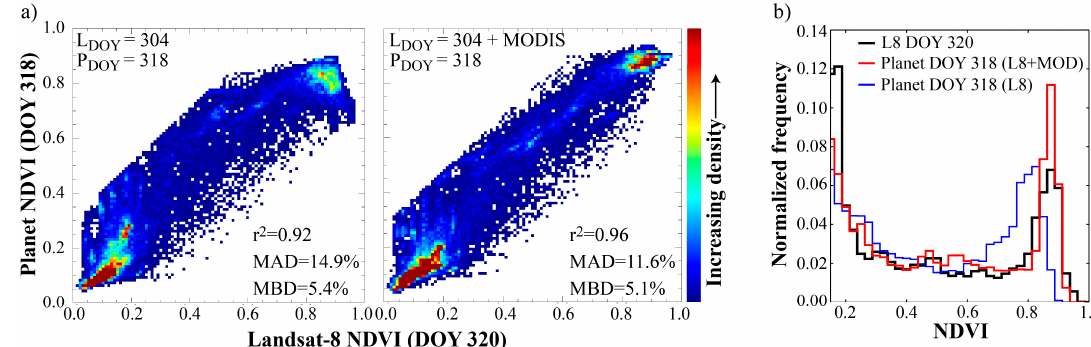
Figure 5. ( a ) Density scatter plots intercomparing Landsat-8 and Planet NDVI. In the leftmost plot, Planet NDVI on DOY 318 was estimated from Cubist regression models using Landsat NDVI from DOY 304 as training data. In the rightmost plot, MODIS NDVI from DOY 304 and 318 were used to inform on the change in cover conditions occurring between the Landsat and Planet overpasses; ( b ) Normalized frequency distributions of the Landsat-8 and Planet NDVI using DOY 304 as the Landsat training base. Note that the Planet data have been resampled to 30 m resolution to facilitate a scale consistent intercomparison and statistic